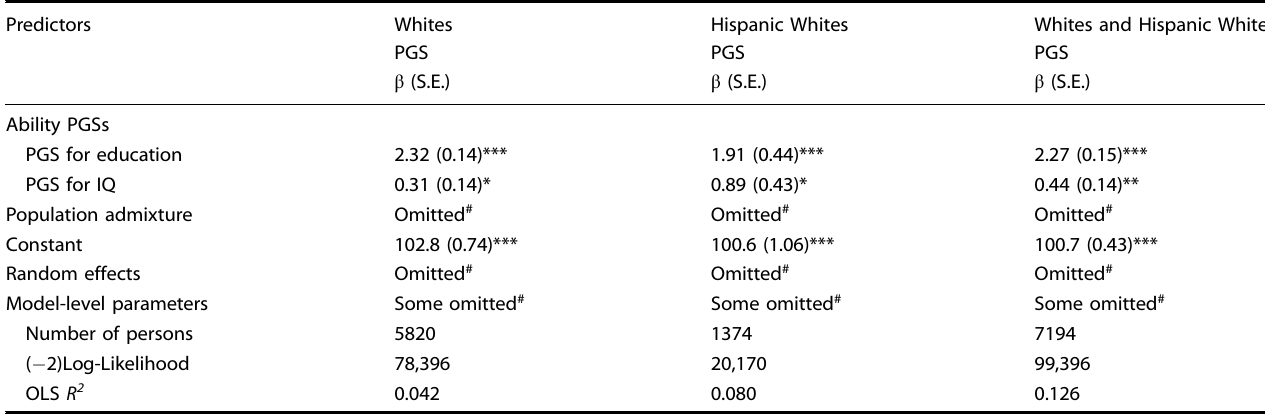
Table 3. Multilevel models of Wave-1 and 3 verbal ability showing coef fi cients (standard errors) of ability-related PGSs.